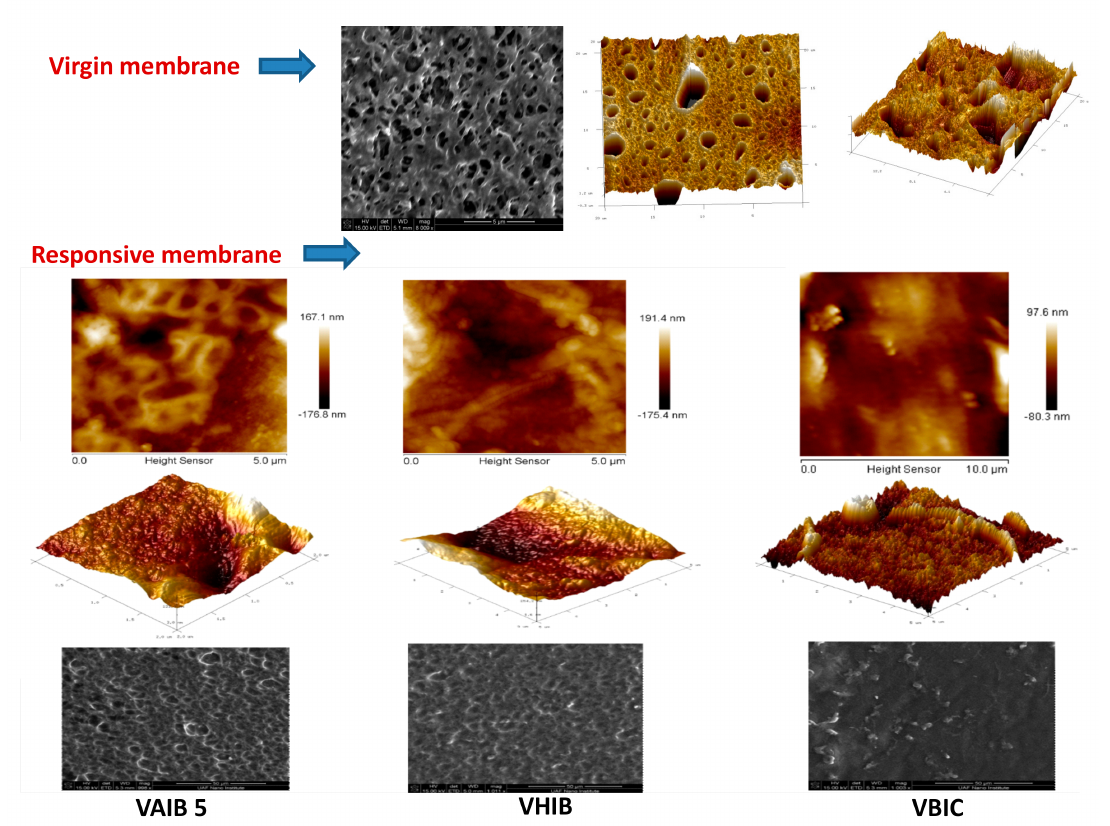
Figure 5. AFM and SEM images of virgin and responsive